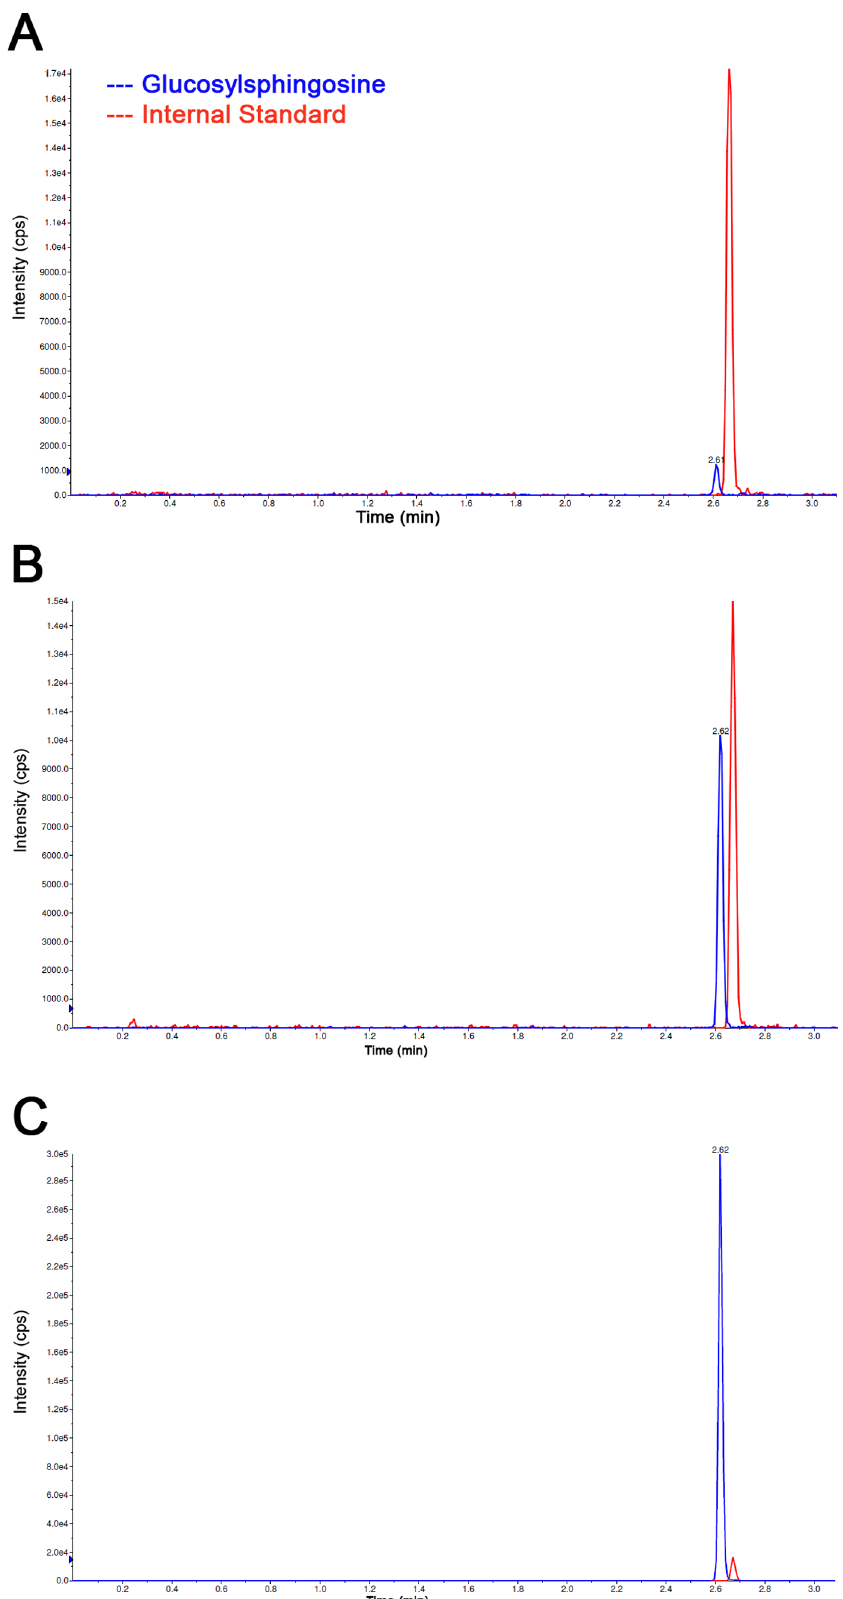
Figure 2. Analysis of Glucosylsphingosine and Internal Standard in different samples. Measurement of Glucosylsphingosine (first peak in chromatograms (blue), second peak in chromatograms is Internal Standard (red)) in a healthy control (1.71 ng/ml) (A) and two differently affected